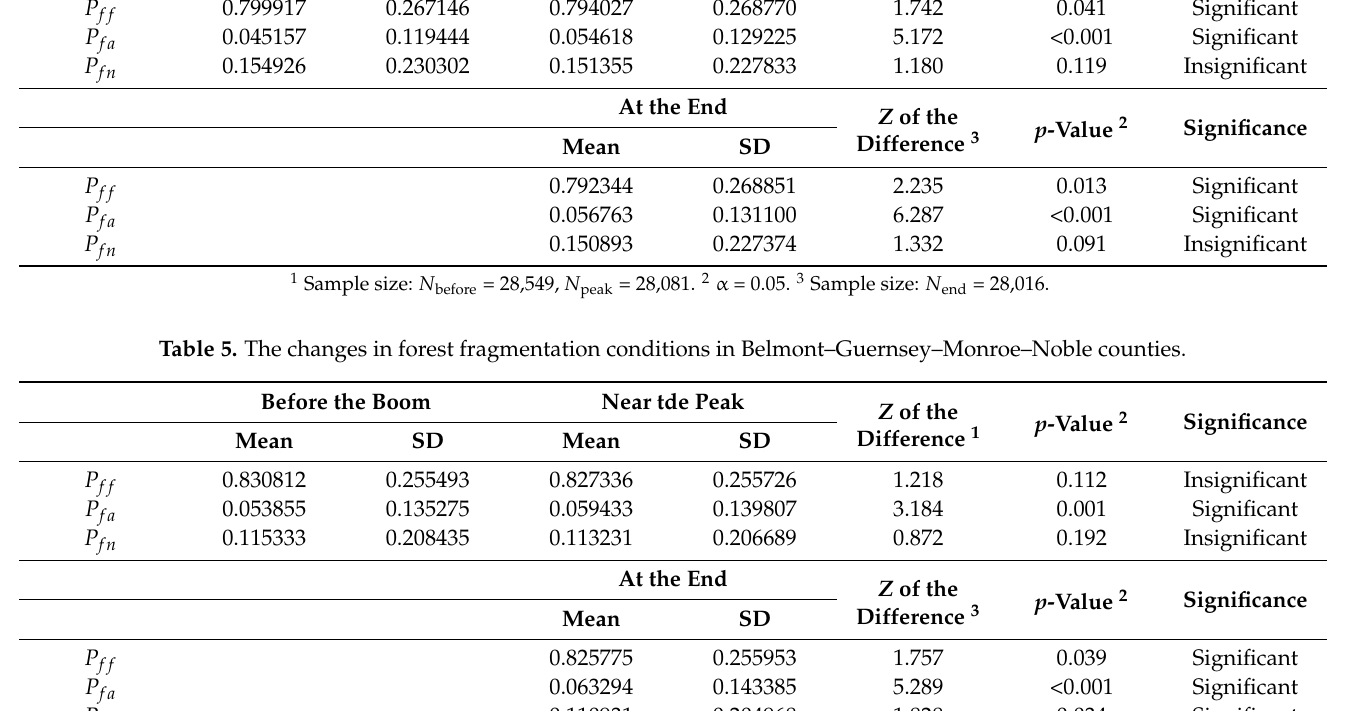
p -Value 2 Difference 1